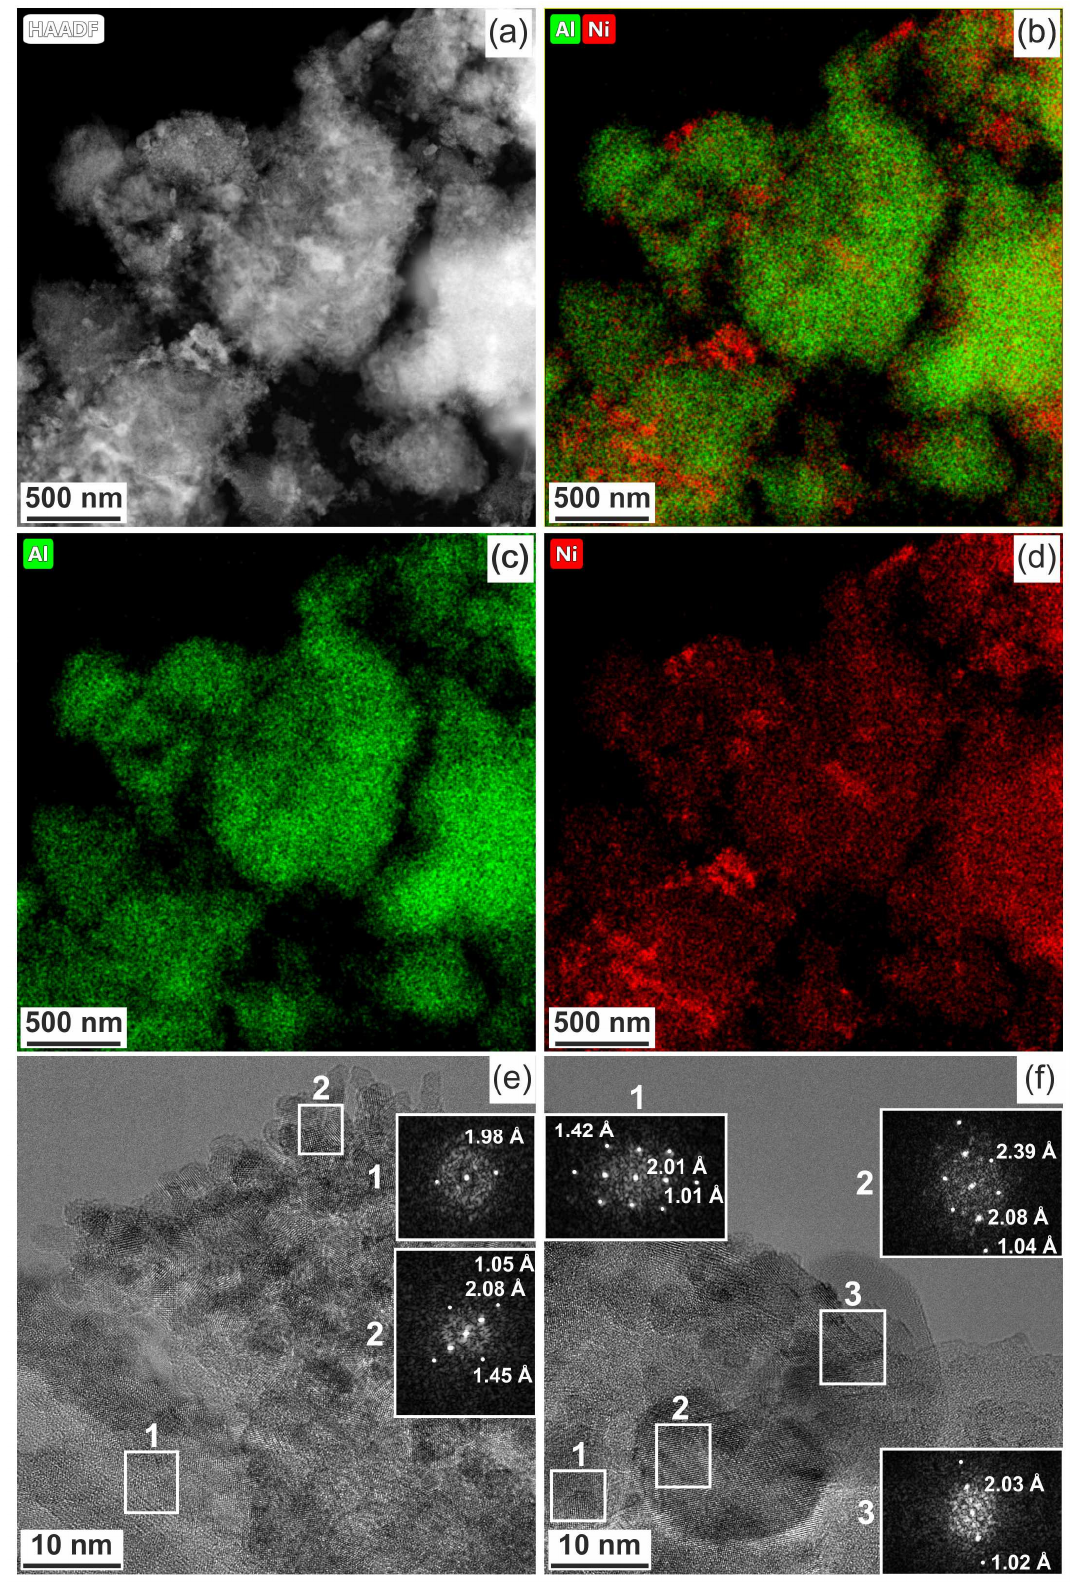
Figure 8. Ni-Al 2 O 3 -SSC catalyst: ( a – d ) compositional elemental mapping and ( e , f ) fast Fourier transform (FFT) patterns are calculated from the TEM image of individual particles.